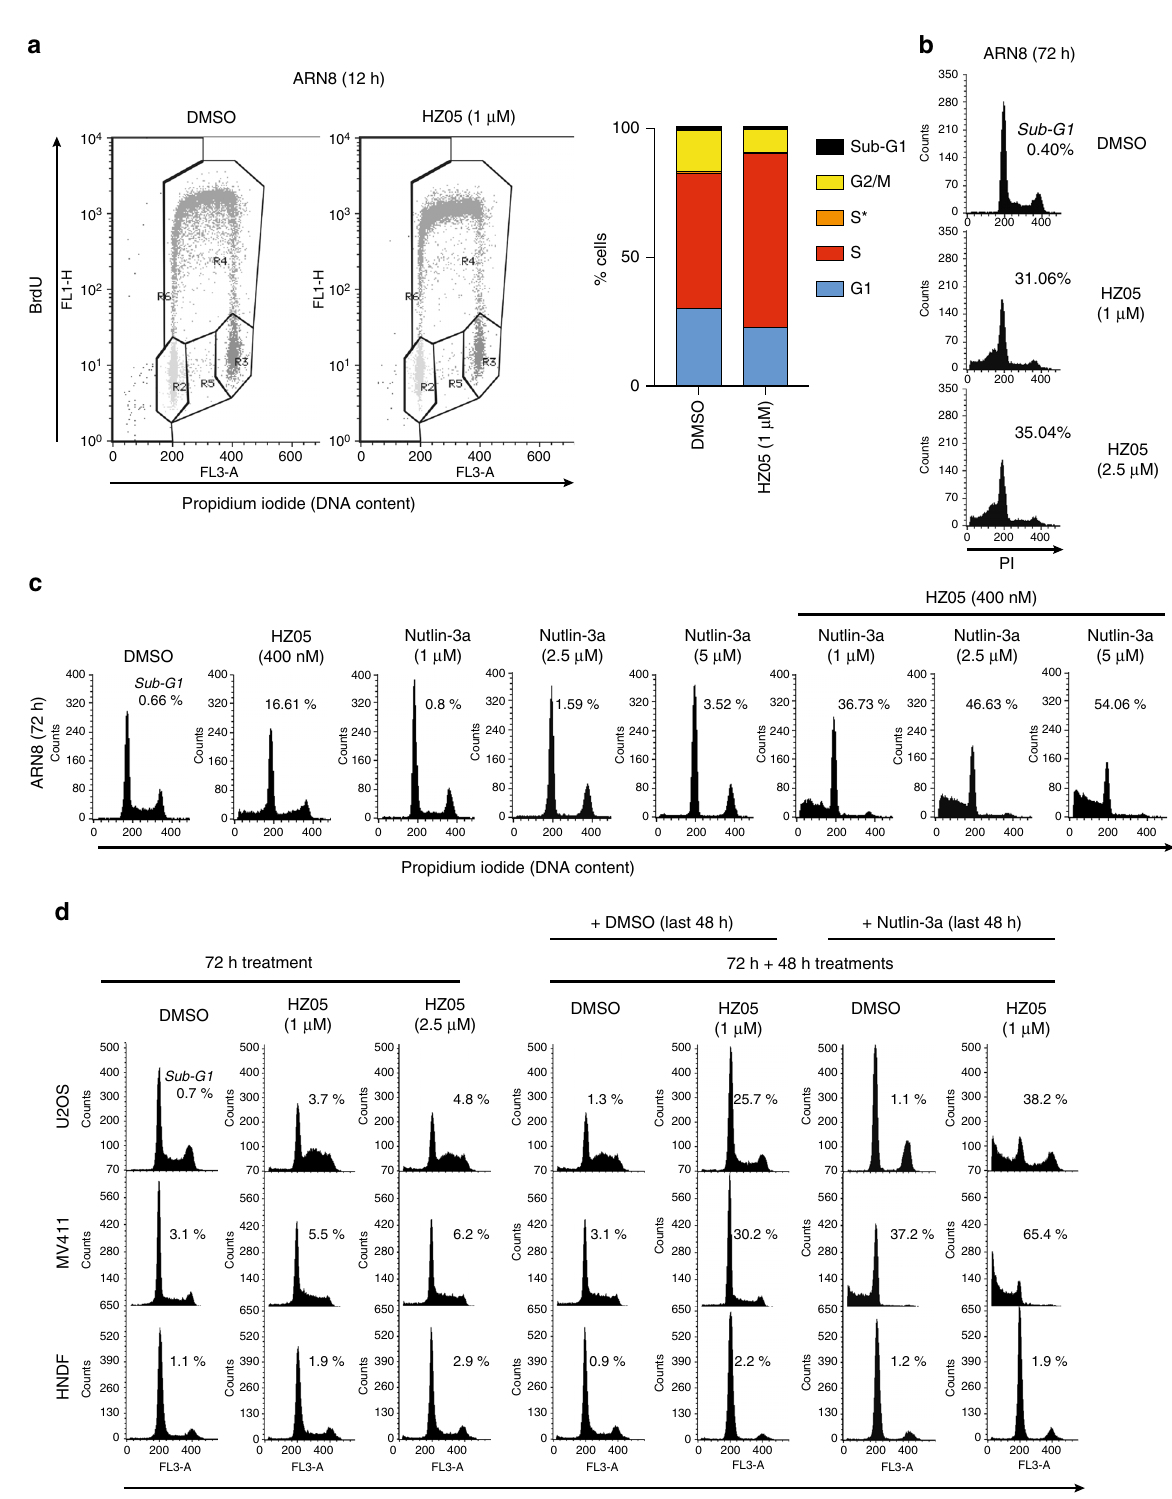
Fig. 6 HZ05 leads to an enrichment of cancer cells in S-phase. a ARN8 cells were treated with vehicle (DMSO) or HZ05 for 12 h and analyzed using BrdU/ PI fl ow cytometry. S* indicates cells with a DNA content between 2N and 4N that do not incorporate BrdU. b ARN8 cells treated for 72 h as indicated and then analyzed using PI fl ow cytometry. Numbers correspond to percentage sub-G1 cells. c ARN8 cells were treated with vehicle (DMSO), HZ05, nutlin-3a, or the combination for 72 h. Cells were analyzed by fl ow cytometry after staining with PI. Numbers indicate % of sub-G1 cells. d U2OS, MV411, and HNDF cells were treated with vehicle (DMSO) or HZ05 for 72 h ( fi rst three columns). In the next four columns, cells were treated for 72 h with either HZ05 or vehicle (DMSO) followed by re-addition of vehicle (DMSO) or HZ05 for an additional 48 h with or without 2 μ M nutlin-3a. Cells were analyzed by fl